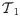
The transformation T1 in the proof of Proposition 21.